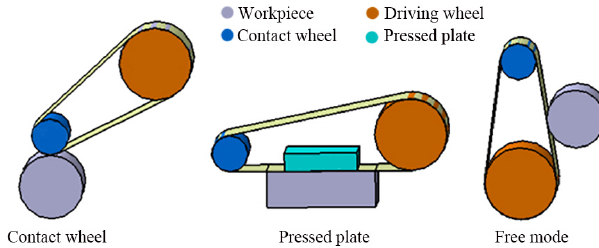
Figure 1. Three kinds of belt